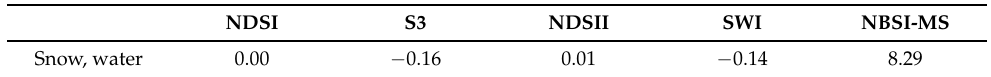
Table 11. The Snow-Cover Indices separation values between snow and water in the Greenland region. Note: The values were computed using Equation